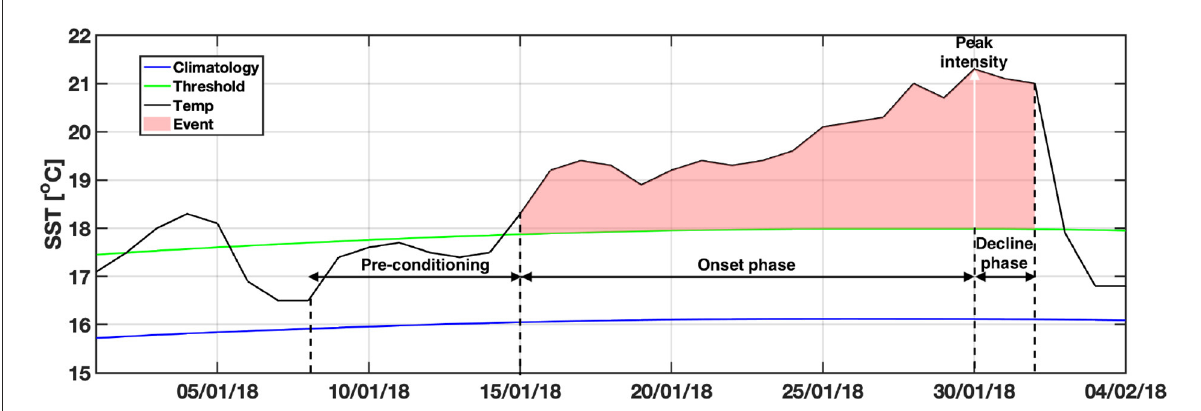
FIGURE2 A detected event from the PML record showing the sea temperature climatology (blue), threshold (green), and temperature (black). The event is highlighted in red with the three MHW phases (pre-conditioning, onset, and decline) illustrated in black.